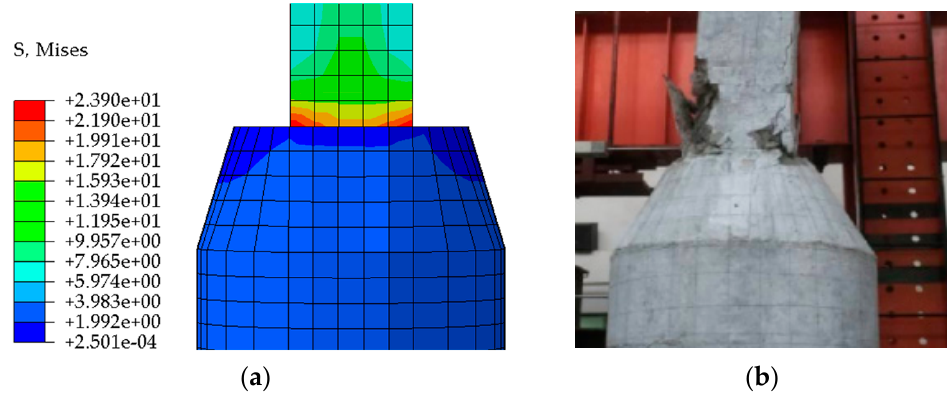
Figure 9. Comparison of simulation and experimental results of USSRC-LCRC1: ( a ) Finite element stress cloud diagram; ( b ) Test damage pattern.